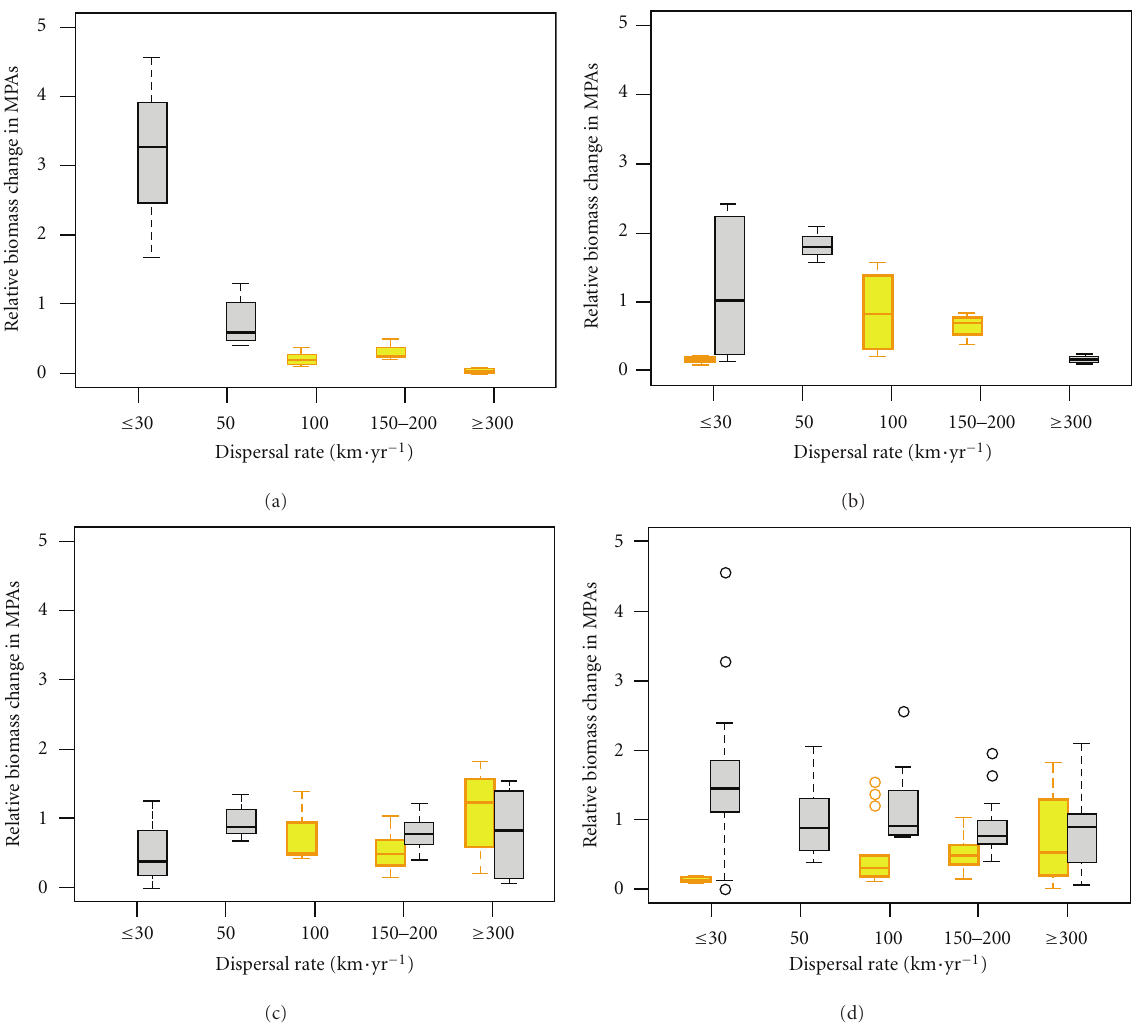
Figure 4: Influence of dispersal rate on biomass density change. The relative change in biomass of fish functional groups obtained in the three analysed MPAs after 20-year simulation using Ecospace model under no fishing scenario was combined and grouped into five classes according to the dispersal rates (shown on x axis). The four panels group the functional groups by trophic level ((a) 2–2.5; (b) 2.5–3; (c) 3–3.5; (d) > 3.5) Box plots (grey: adults and yellow: juveniles) are drawn to show the range in biomass